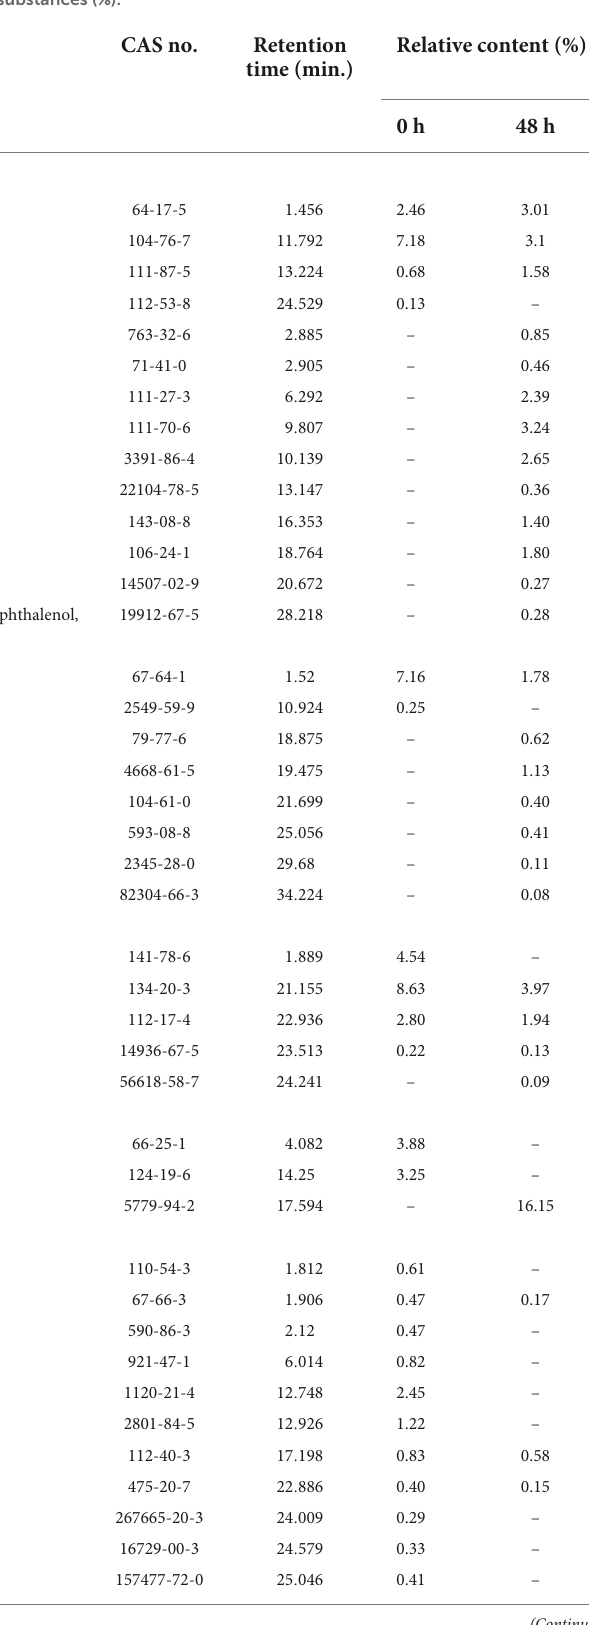
TABLE 6 Relative content change of fermented and unfermented flavor substances